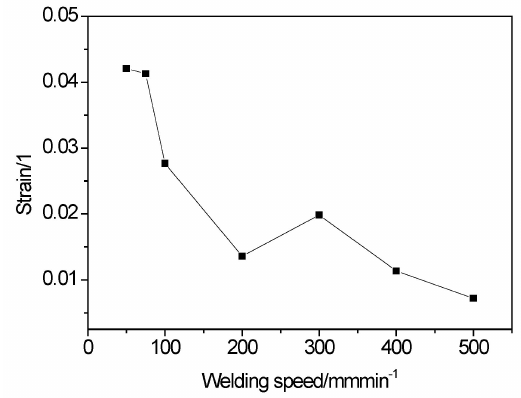
Figure 5. Overall engineering strain of robotic FSW 2198 Al − Li alloys.